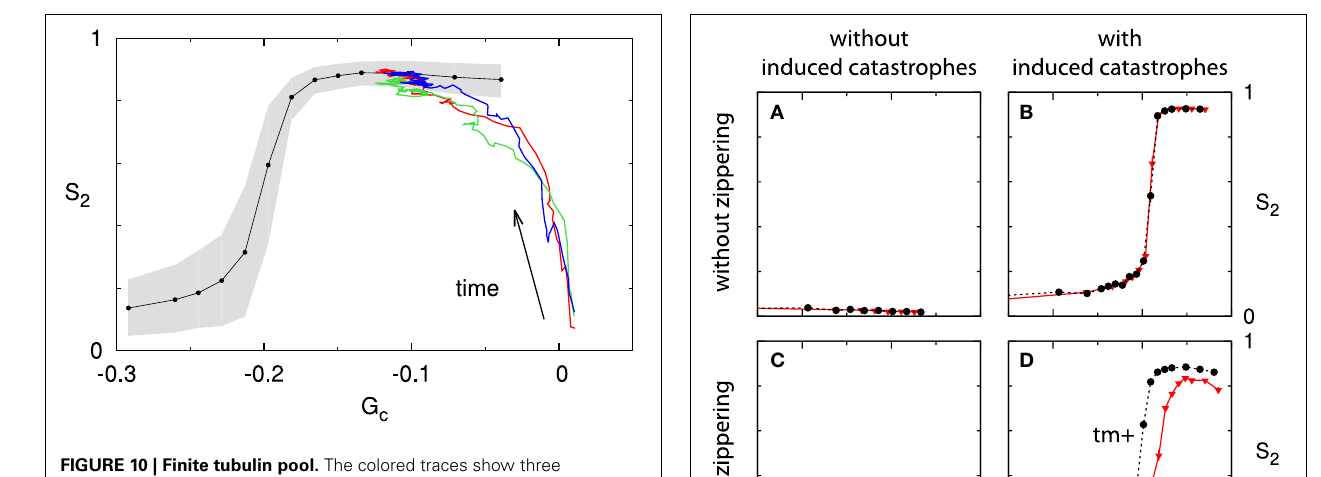
Figure 11 : the column indicates the presence of induced catas- trophes (left: without; right: with) and the row the presence of zippering (top: without; bottom: with). Furthermore, each panel contains curves for systems with and without minus end treadmilling.